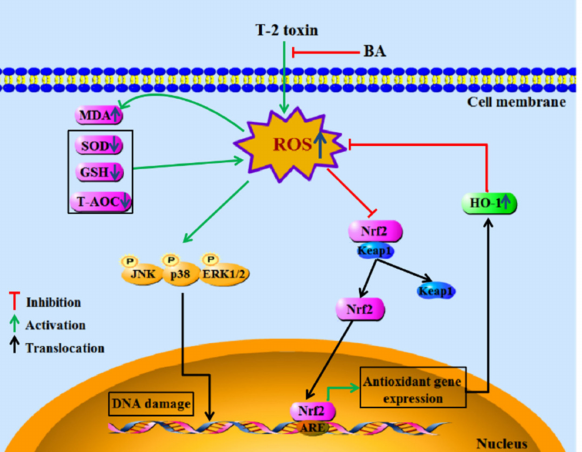
Figure 7. The main mechanism of BA in protecting splenocytes against oxidative damage caused by T-2